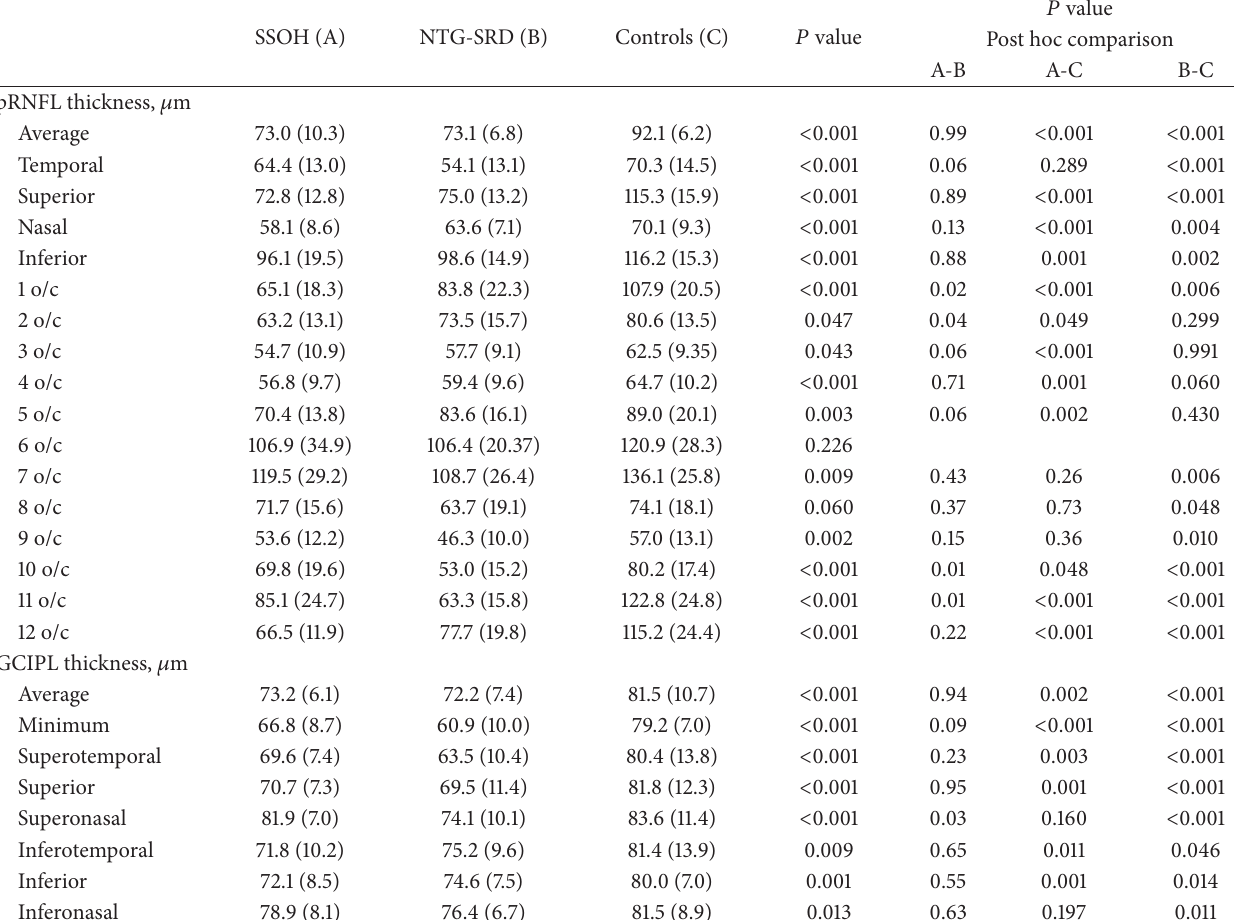
GCIPL: ganglion cell inner plexiform layer; NTG-SRD: normal tension glaucoma with superior retinal nerve fiber layer defect; pRNFL: peripapillary retinal nerve fiber layer; SSOH: superior segmental optic